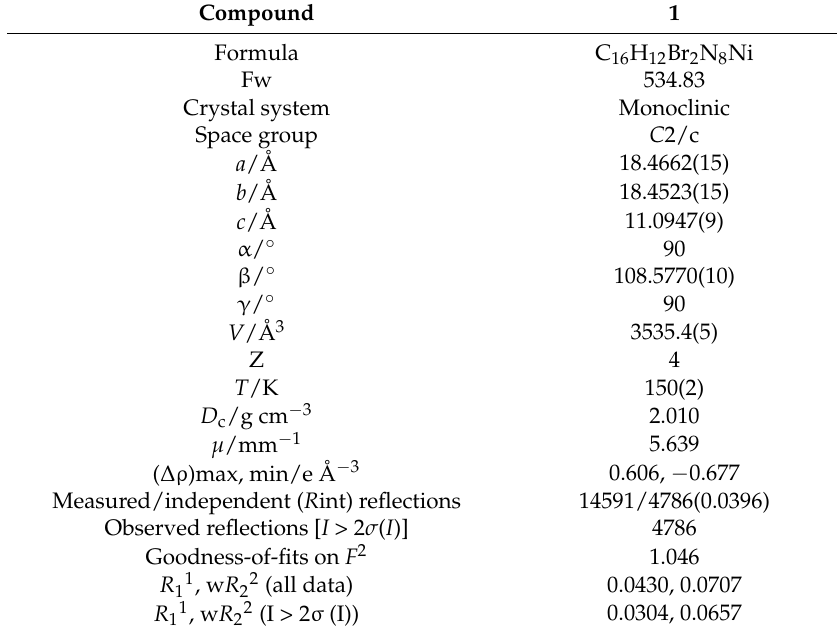
Table 1. Crystallographic data for compound 1 .